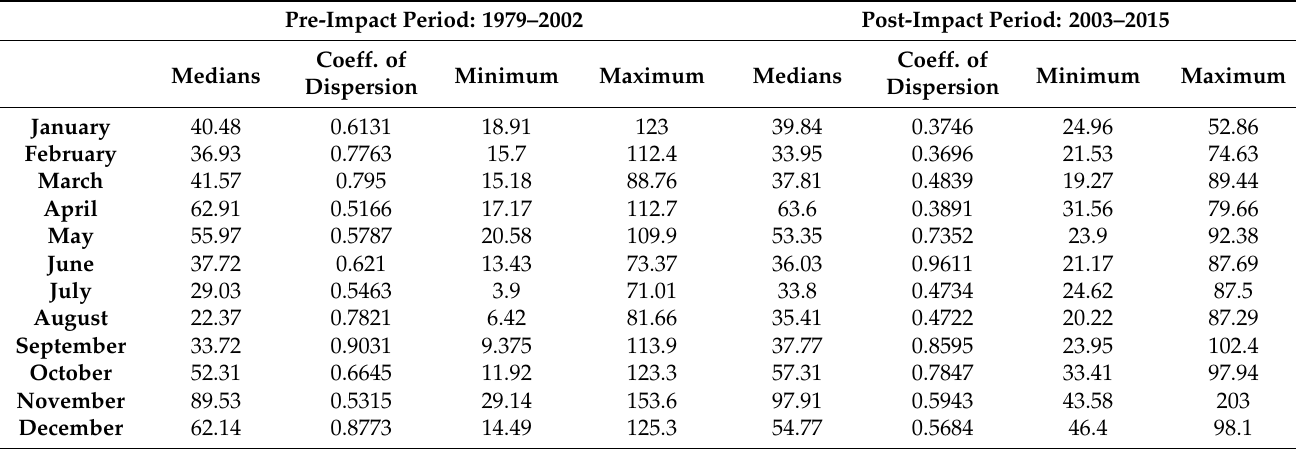
Table 5. Comparison of Min, Max, and Median flows in pre- and post-impact